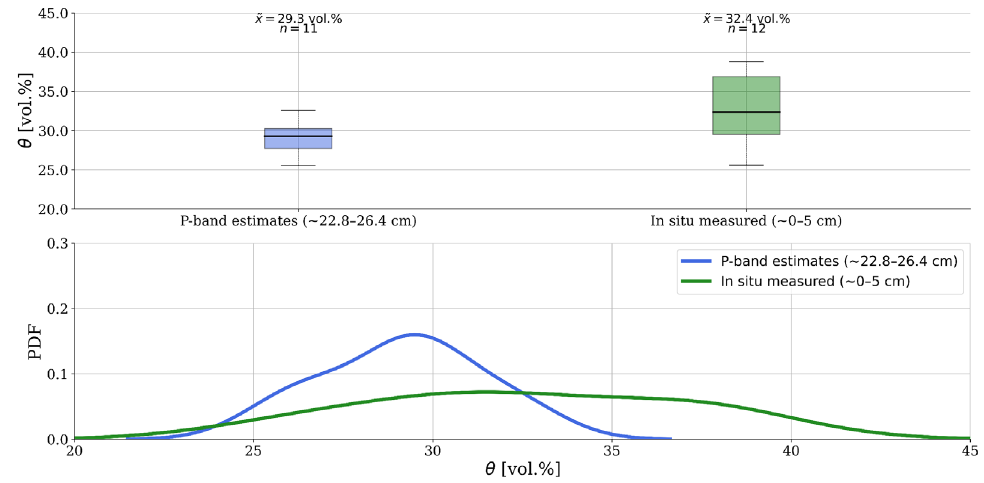
Figure 11. Comparison of retrieved soil moisture values, estimated with the proposed P-band SAR method and converted from permittivity according to the dielectric mixing model from [71], with in situ measured soil moisture values from various networks (cf. Section 2) at the AirMOSS monitoring site Harvard Forest, MA. (cid:101) x represents the respective median value, n is the total amount of values per boxplot.